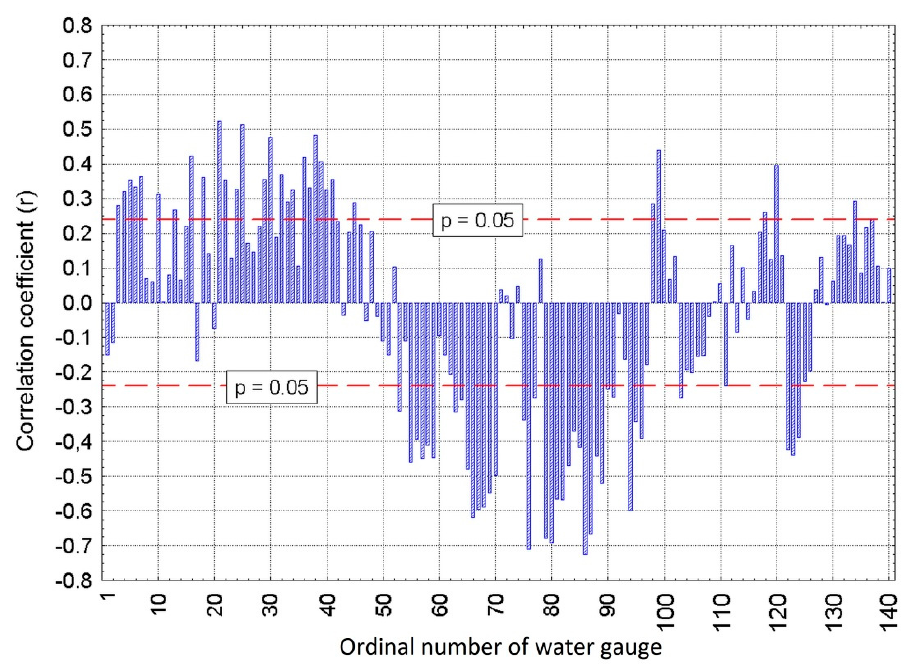
Figure 10. Correlation coefficients (r) between 2 EV of the set of ND LF and ND LF per year at individual water gauges in Poland in 1951–2020. The lower boundary of statistical significance ( p = 0.05) is marked with the dashed line.